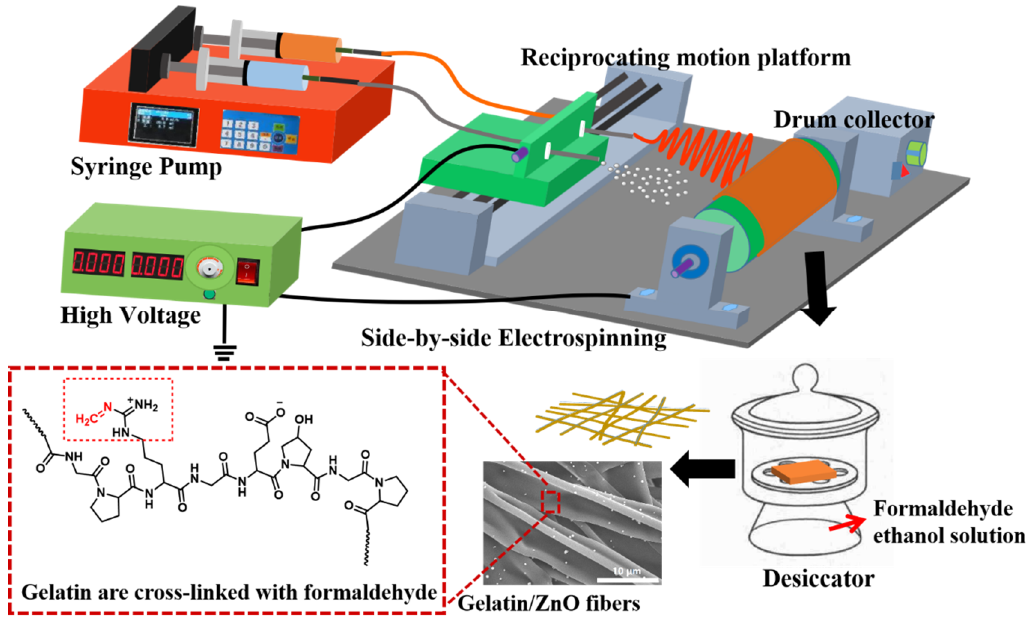
Figure 1. Schematic illustration of the fabrication of gelatin/ZnO fibers by side-by-side electrospinning.